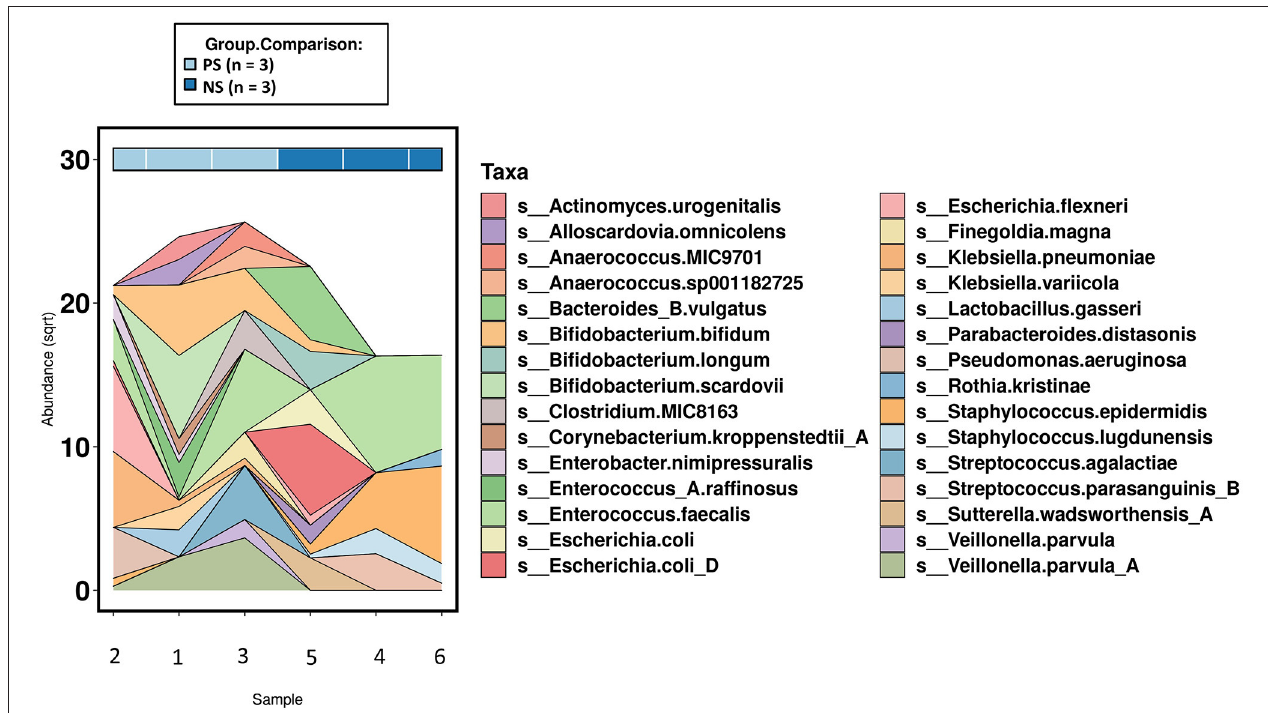
FIGURE 3 | Area chart of species level abundances (top 30-most abundant)across the subset of samples that underwent shotgun metagenomics ( n = 6). PS, probiotic-supplemented; NS, not supplemented; sqrt, square root transformation.